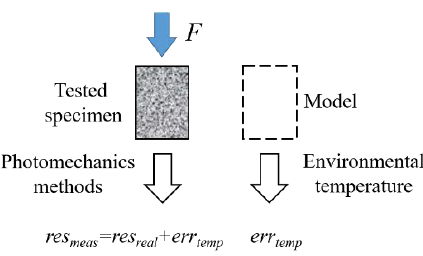
Figure 11. Compensation principle of the model compensation method.